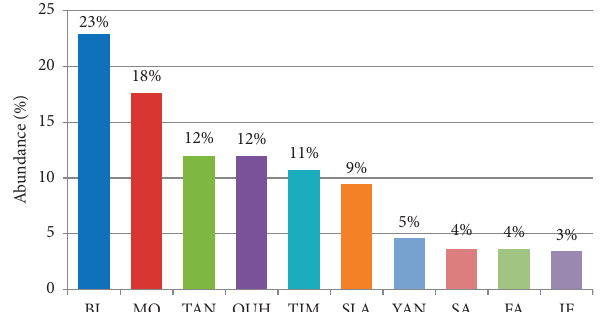
Figure 3: Abundance of sand fies in the ten villages studied